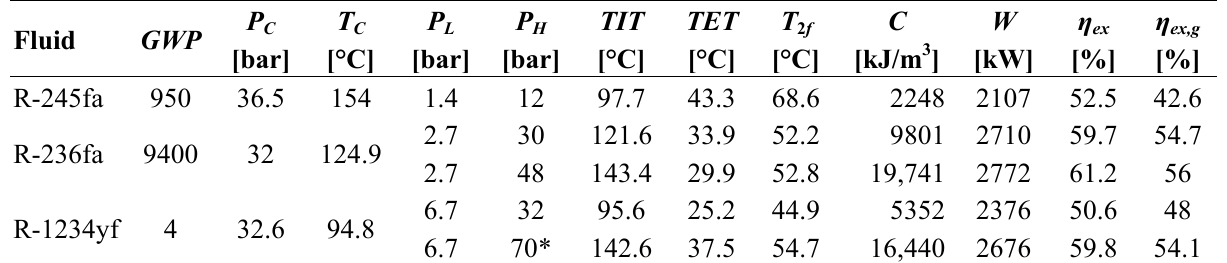
Table 2. Almost dry resource: cycle